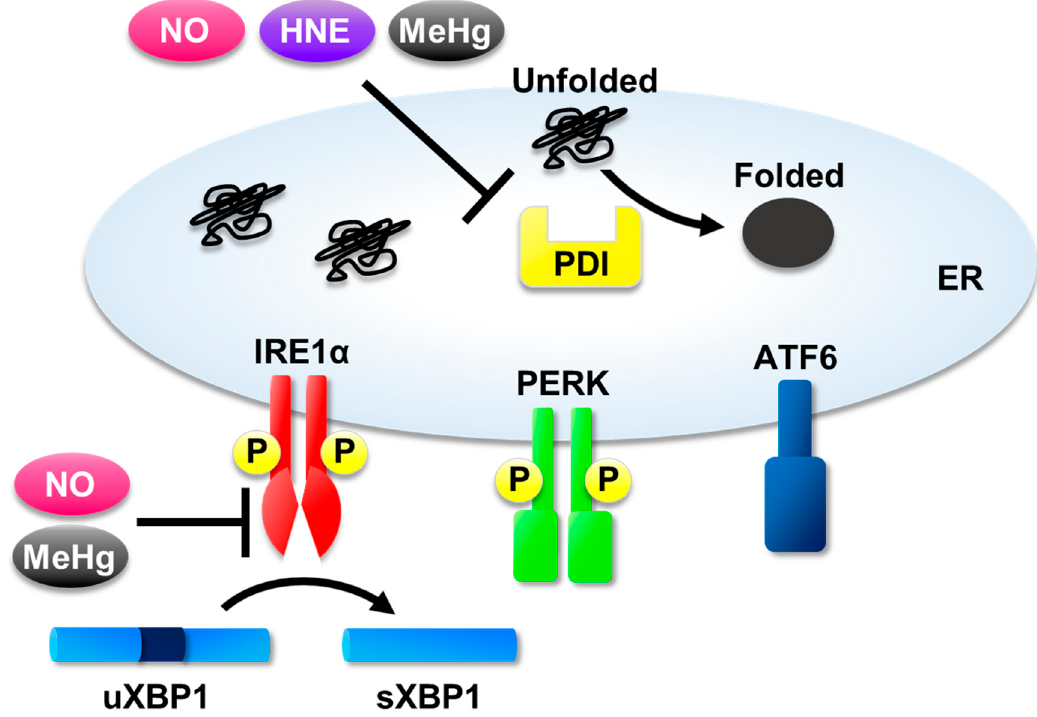
Figure 1. Targets of electrophiles in the unfolded protein response (UPR). NO, nitric oxide; HNE, 4-hydroxynonenal; MeHg, methylmercury; P, phosphate group; top arrow, protein folding process by PDI; lower arrow, RNA splicing process by IRE1 α .